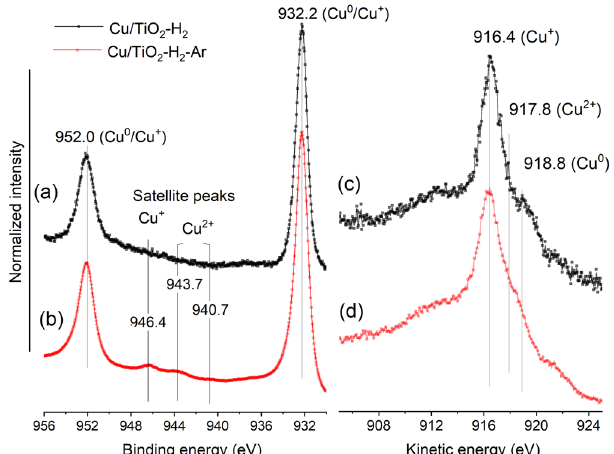
Fig. 1 Copper X-ray photoelectron and X-ray-excited Auger electron spectra. Cu 2p X-ray photoelectron spectra ( a , b ) and Cu LMM X-ray- excited Auger electron spectra ( c , d ) of: a , c Cu/TiO 2 – H 2 , after the